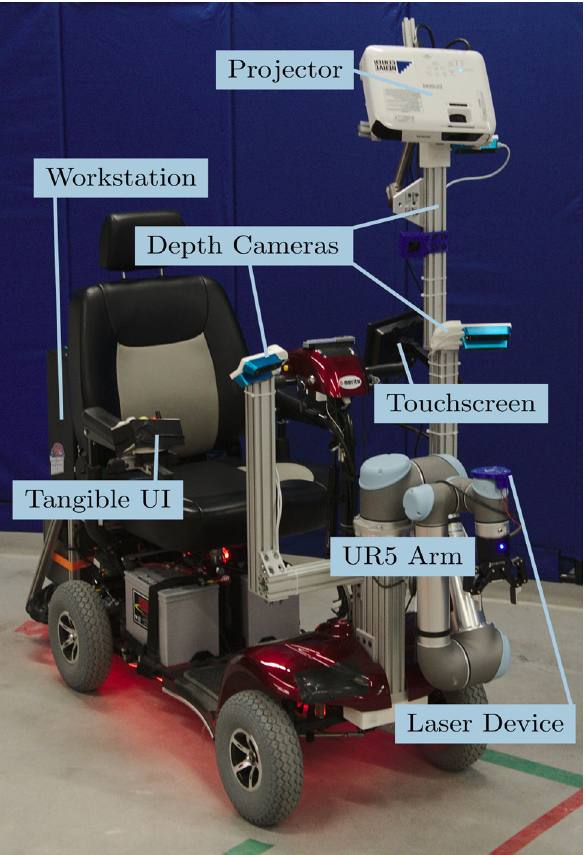
Figure 2: An image of the assistive robot system, with a Universal Robots UR5 robot arm out fi tted with a Robotiq 2F - 85 gripper mounted on a Merits Pioneer 10 mobility